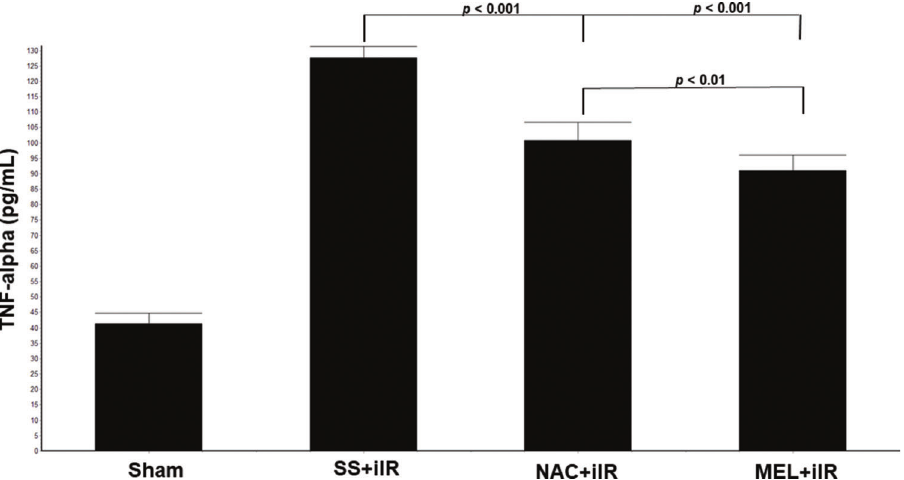
Figure 5 - Diagram showing the TNF-alpha levels of the animal groups. Note that TNF-alpha levels were significantly reduced before NAC and melatonin administration, the reduction was more evident in the MEL group. Data are shown as the mean ± standard deviation of seven rats in each group. Sham: control; SS + iIR: control intestinal ischemia-reperfusion (iIR); NAC + iIR: NAC administration and iIR; MEL + iIR: Melatonin administration and